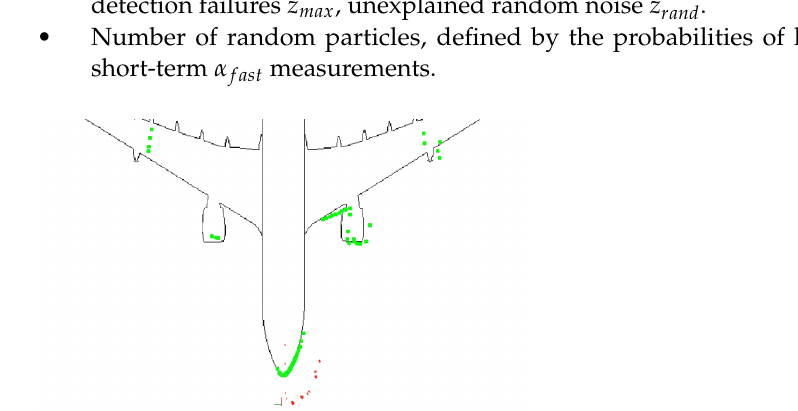
Figure 2. Example of 2D localization using AMCL algorithm (red), 2D laser Scan (green) and an Occupancy grid map